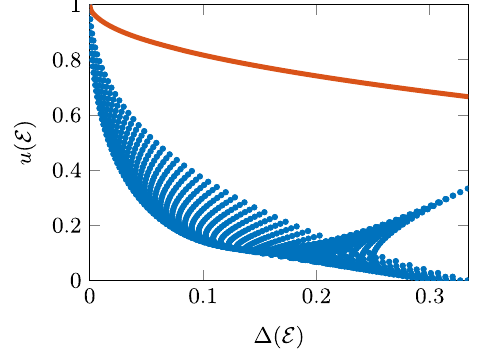
FIG. 5. Trade-off between the deviation from energy conser- vation Δ ð E Þ and unitarity u ð E Þ for U(1)-covariant channels Each blue dot represents a ½ Δ ð E Þ ; u ð E Þ(cid:2) pair for a qubit channel with fixed P E and optimal unitarity (the two parameters defining P E , E ≤ 1 are taken as points from the lattice ½ 0 ; 1 (cid:2) × ½ 0 ; 1 (cid:2) 0 ≤ P E 00 ; P 11 with lattice constant 0.02). The orange solid line is the upper bound from Eq.